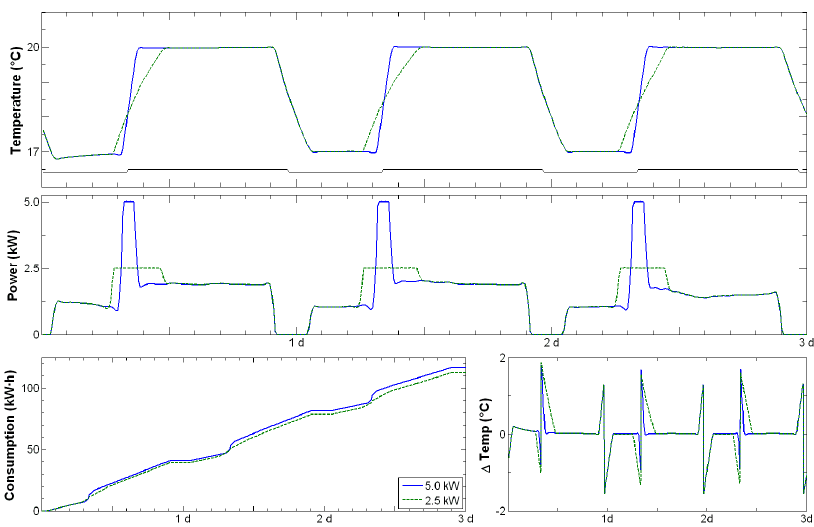
Figure 5. Three days zoom: Indoor temperature, heat power pattern, energy consumption and deviation respect the set point for heat system of 2.5 kW and 5.0 kW. Solid black line represents the variation of the temperature of reference.